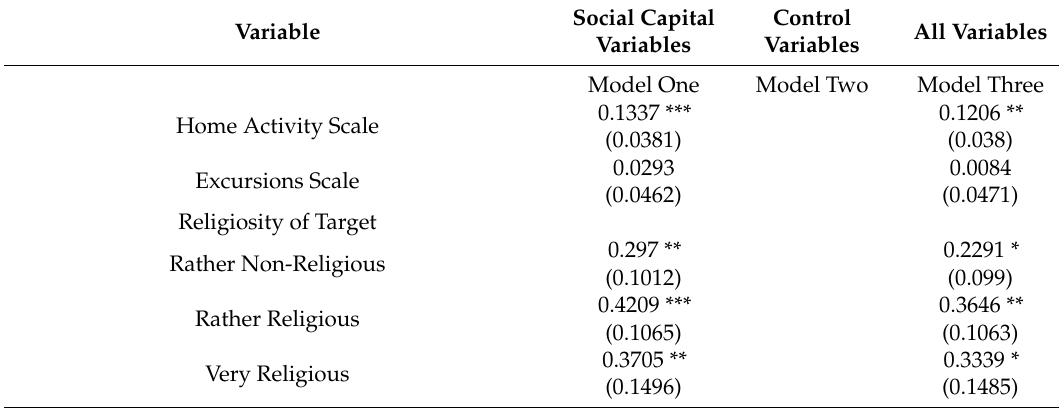
Table 2. Ordinary Least Squares Regression Coe ffi cients for Strengths and Di ffi culties